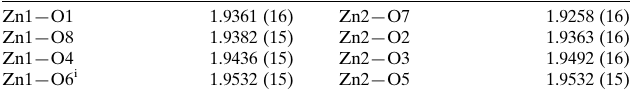
Selected bond lengths (A˚